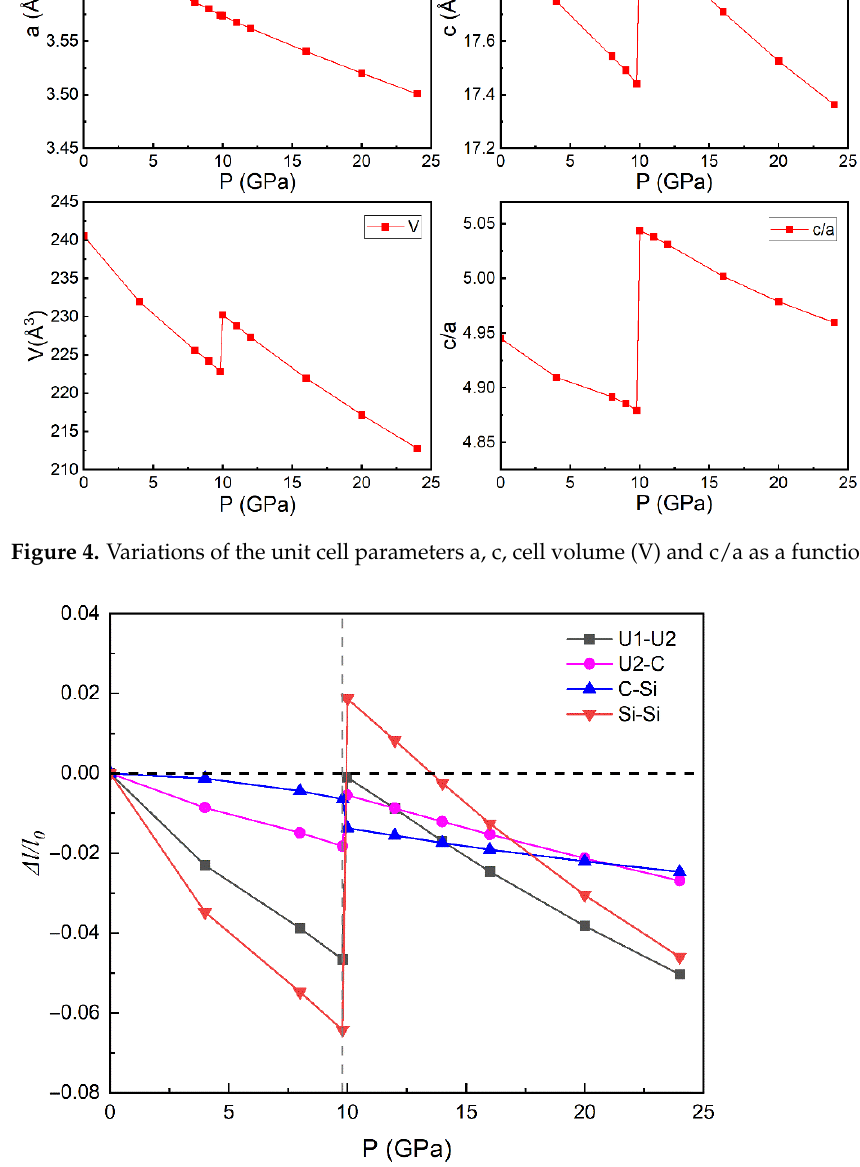
Figure 5. The variation ratios of interatomic distance for U1-U2, U2-C, C-Si, and Si − Si pairs at c axis as a function of pressure. The corresponding interatomic distance at 0 GPa ( l 0 ) is 3.249, 2.293, 1.922, and 3.122 Å.